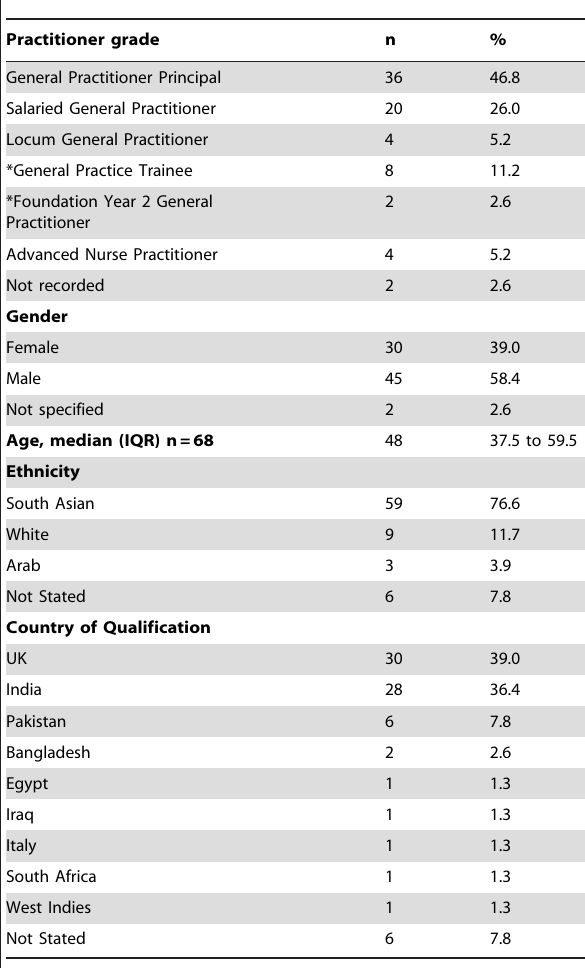
Table 1. Demographic characteristics of practitioners. Table 2. Reported practitioner fluency in other languages